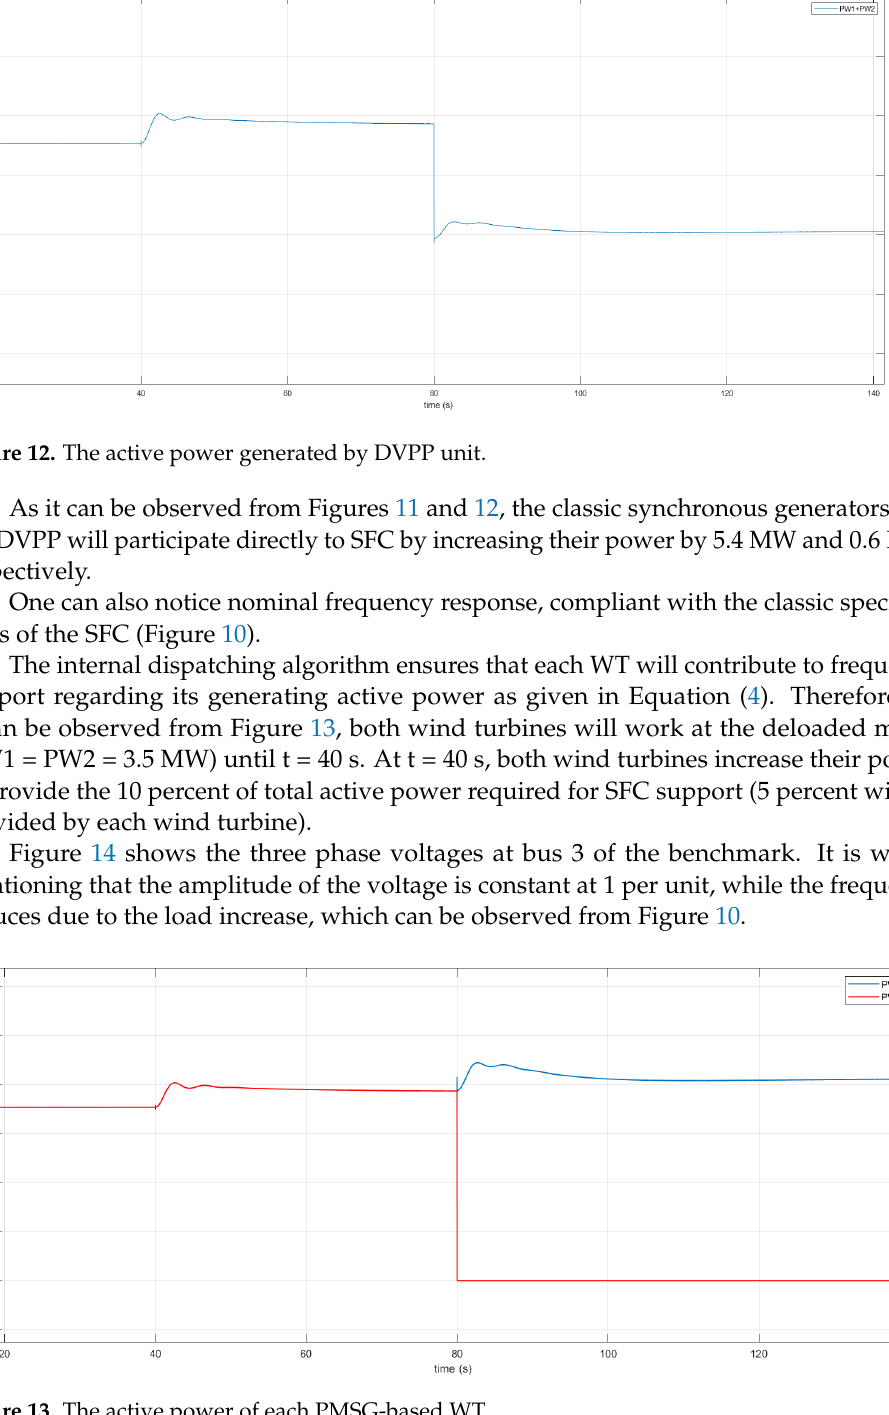
Figure 13. The active power of each PMSG-based